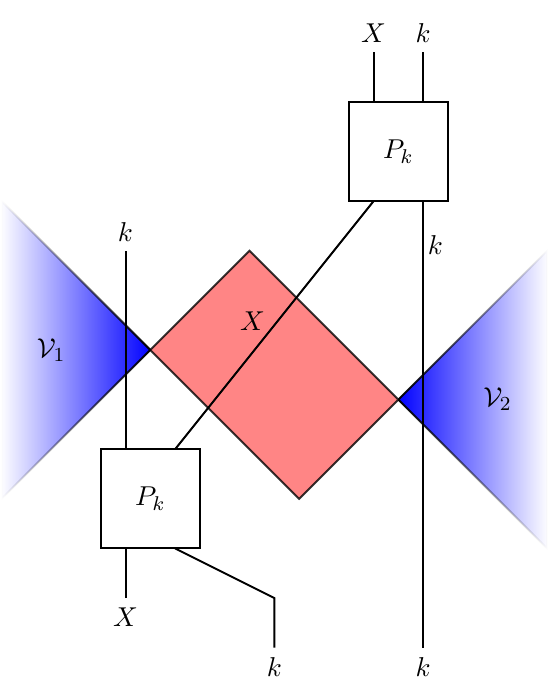
Figure 5. The elementary one-time pad, used in a spacetime context. A pair of correlated, classical bit strings k is prepared at an early time. One copy is sent through V sent near c , then onward through V . Near c the string k is used to encode the message system X . 1 The encoded X is sent through U , then decoded using the copy of k near r . This procedure leads to large I ( V : V ) and large I ( V : V ) 1 2 1 2 | U